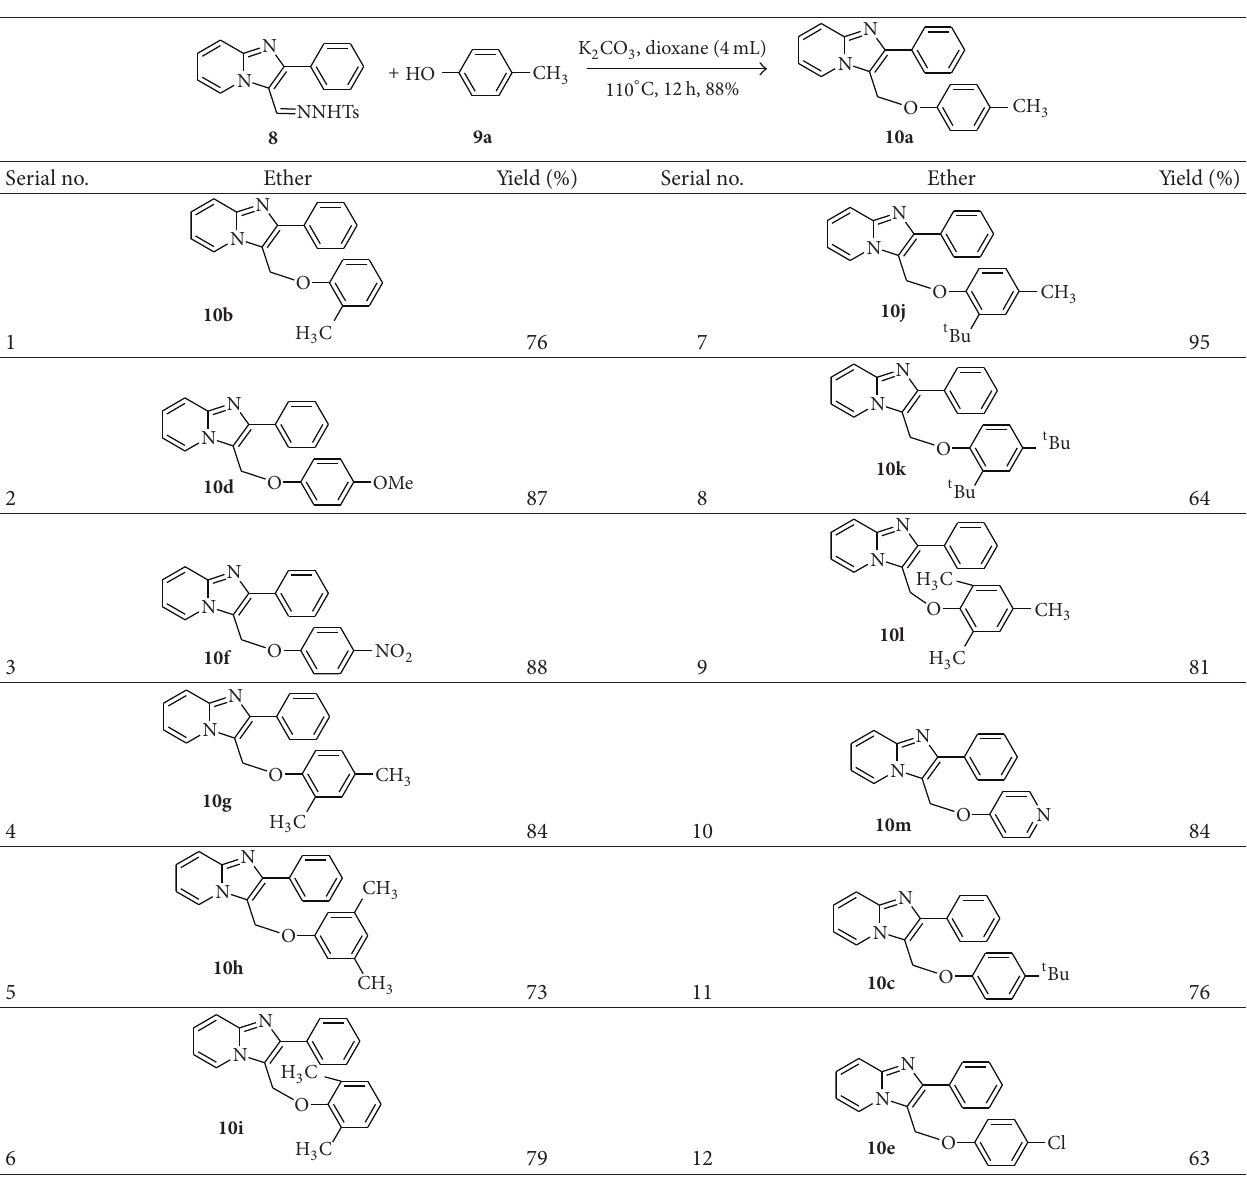
T 1: Scope of the synthesis of C-3-aryl ether substituted 2-phenyl imidazo[1,2- a ]pyridines 10a – 10m . a Reaction conditions: Tosylhydrazone 8 (1.0mmol), phenol (2.0mmol), K